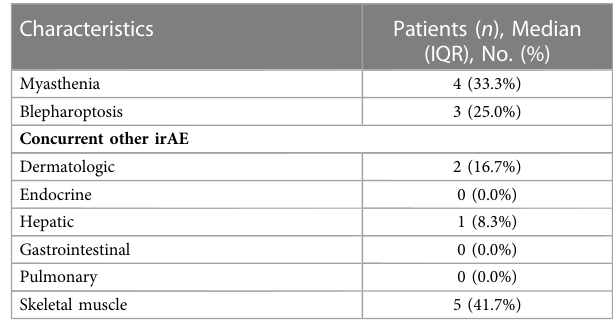
complications ( Table 1 ). The median time of initial systemic corticosteroid use was 5.0 days (range: 0.3 to 17.3) after symptom onset or the detection of abnormal serum markers.